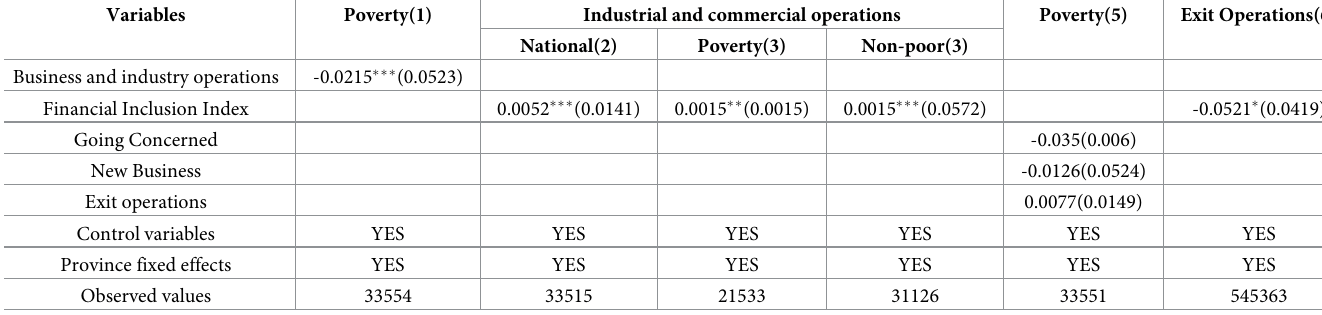
Table 7. Tests on the mechanism of the impact of financial inclusion on household poverty (2SLS